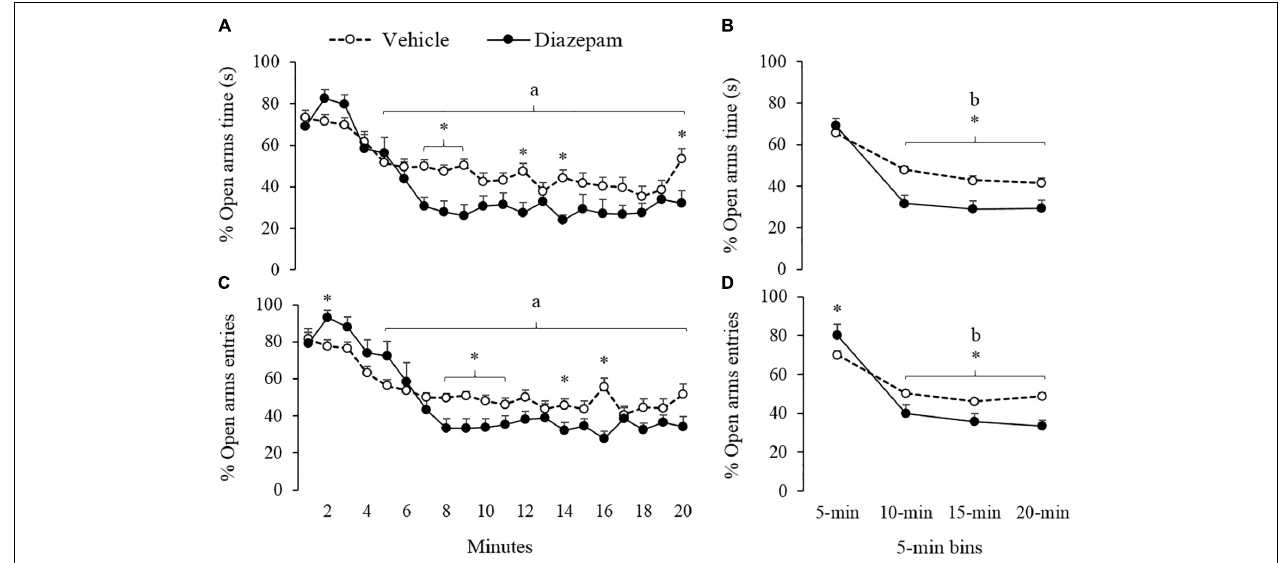
FIGURE 2 | Effect of DZP on escape-related behaviors of gerbils exposed to 20-min session in the EPM – i.e., percentage of time and percentage of entries. The left panels showed minute-by-minute data (Panel A , C ) and right panels show data in 5-min bins (Panel B , D ). After 5-min of exposure to the EPM, DZP reduced escape-related behaviors. a different from minute 1 to 4 for vehicle and DZP group, b different from 5-min bin for vehicle and DZP group, ∗ different from vehicle group ( p <